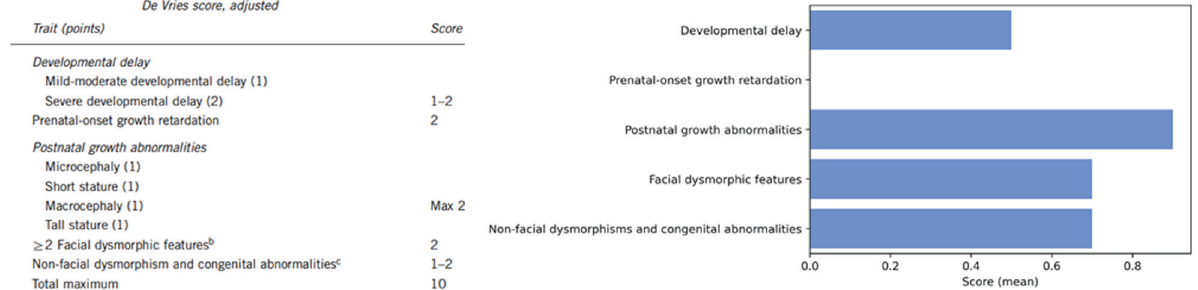
Fig. 1 Adjusted De Vries score [16], with on the right the average scores of the different categories of the De Vries score. The scores are quite evenly distributed among the different categories — apart from prenatal-onset growth retardation, which was not present in our study